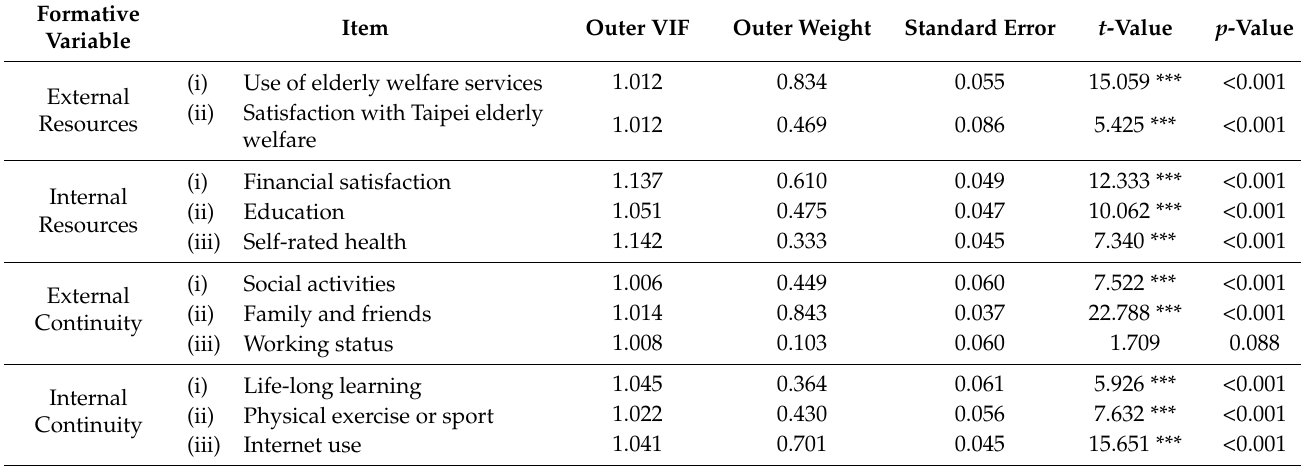
Table 3. The parameters of the measurement